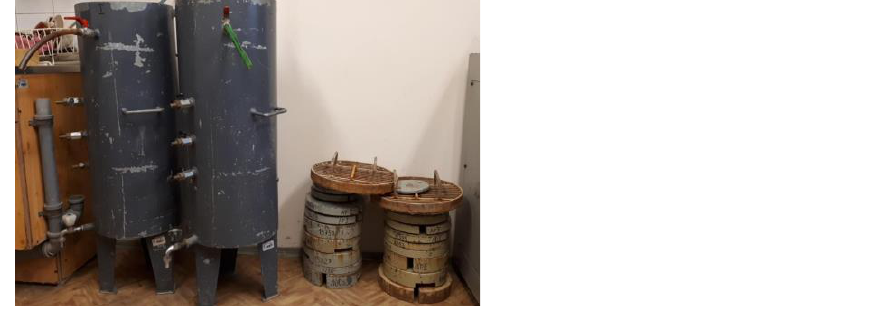
Figure 3. Cylinders of a medium-size permeameter for filtration coefficient testing (A. Gruchot).